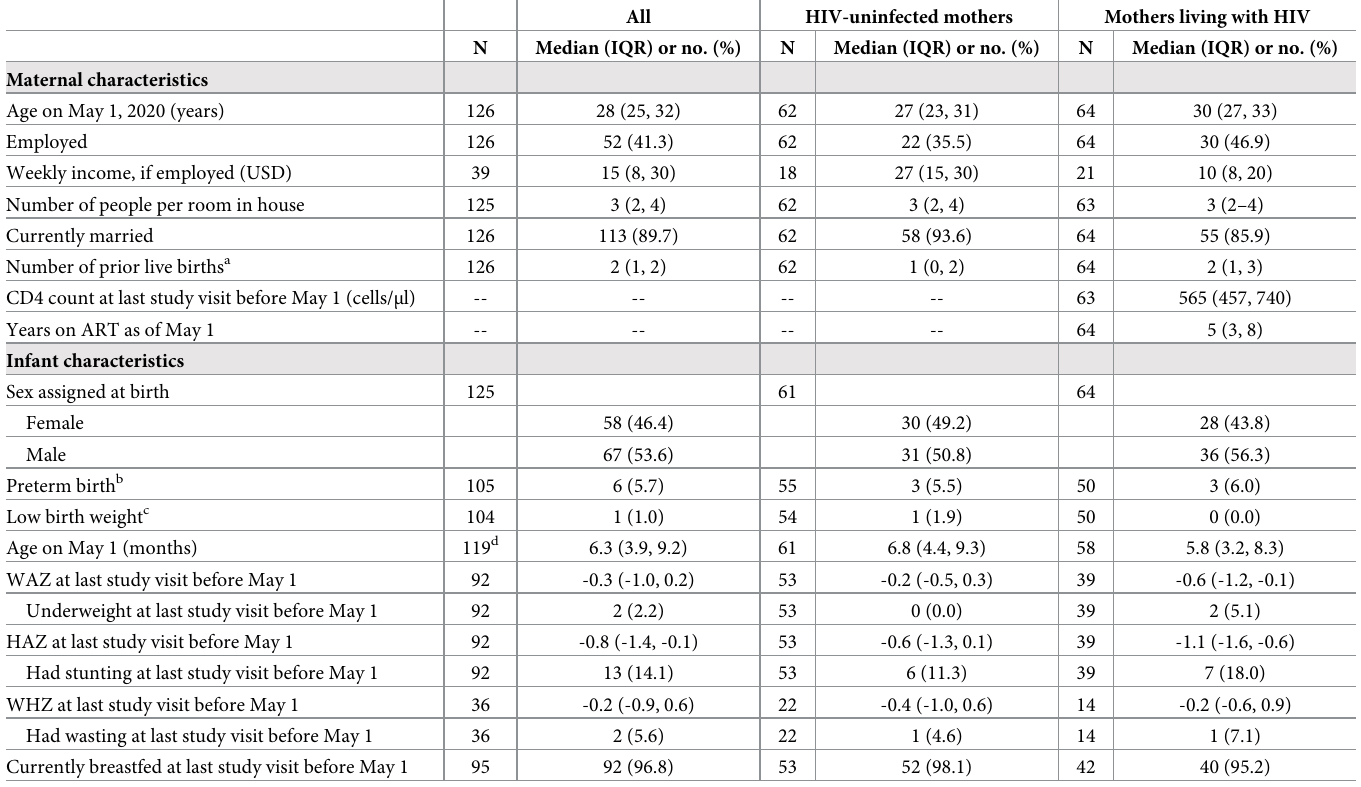
Table 1. Participant